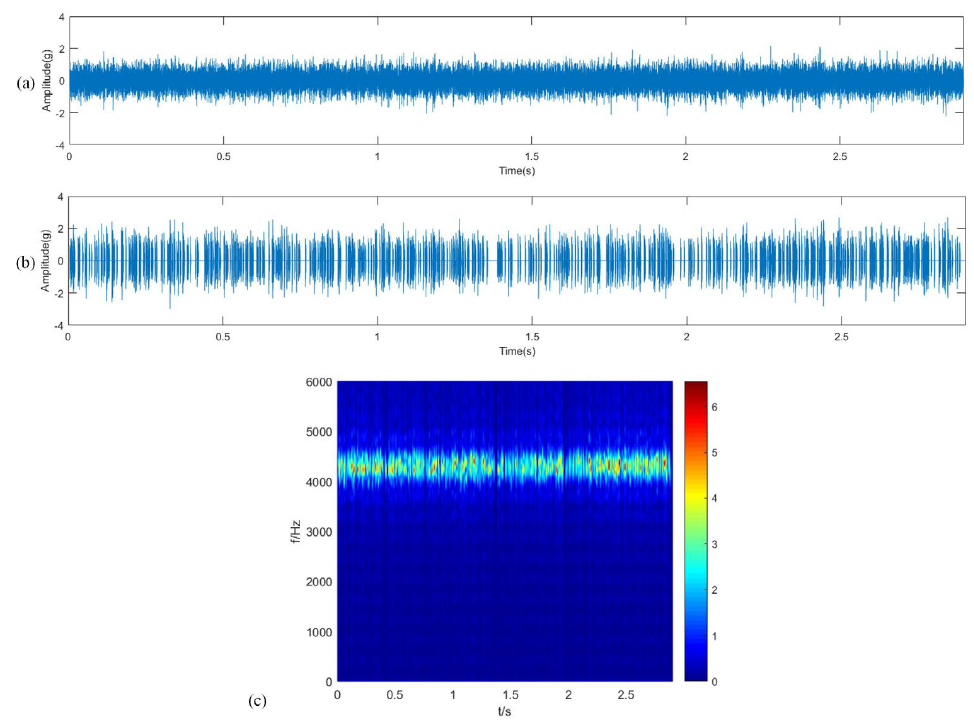
Figure 13. In 95 h: ( a ) Raw vibration signals; ( b ) reconstructed component; ( c ) the STFT of impulse component.